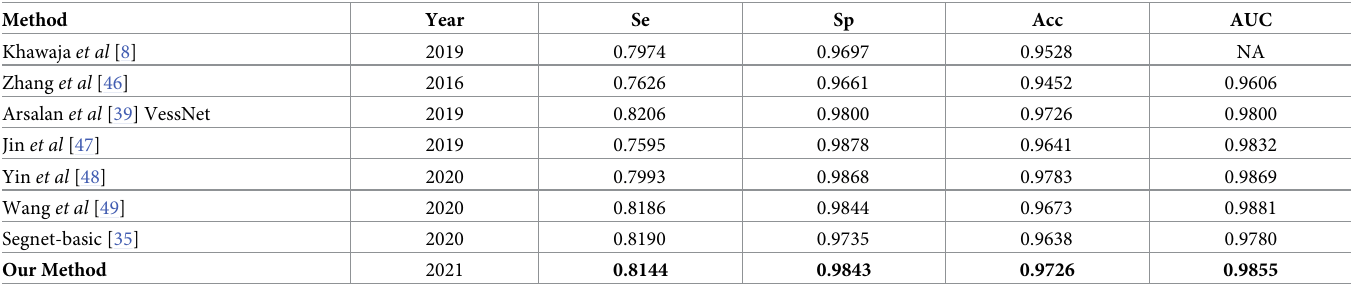
Table 5. Performance comparison of our proposed model on CHASE_DB1 dataset with other existing